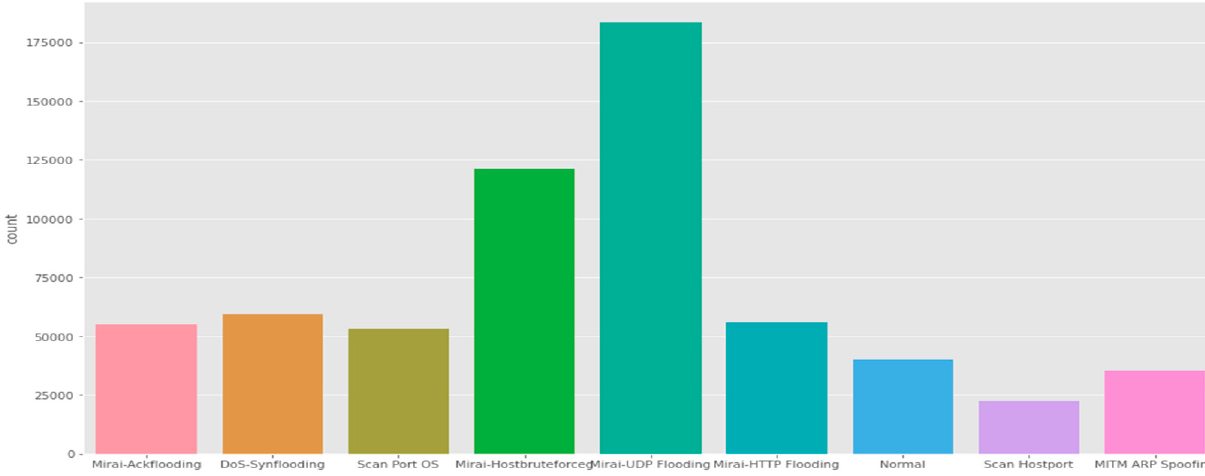
Figure 10. The subcategories of attacks in IoTID20 dataset.